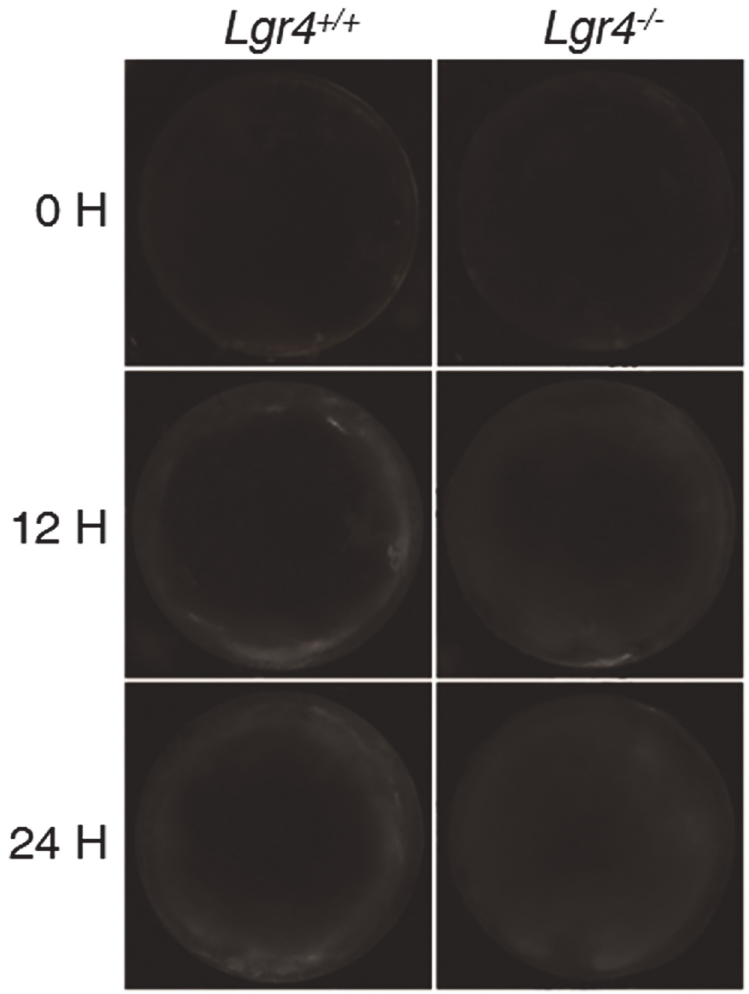
Fig 3. Morphologic changes of murine lenses cultured in the presence of H 2 O 2 . Lenses removed from 30-week-old mice were subjected to peroxidase damage (H 2 O 2 ) and incubated for 24 hours. Lens images were captured on culture plates at 0, 12, and 24 hours after H 2 O 2 treatment using dark field microscopy. Representative images show that the degree of lens opacity in the knockout mice was significantly more than in wild-type mice. All images are representative of at least 3 independent